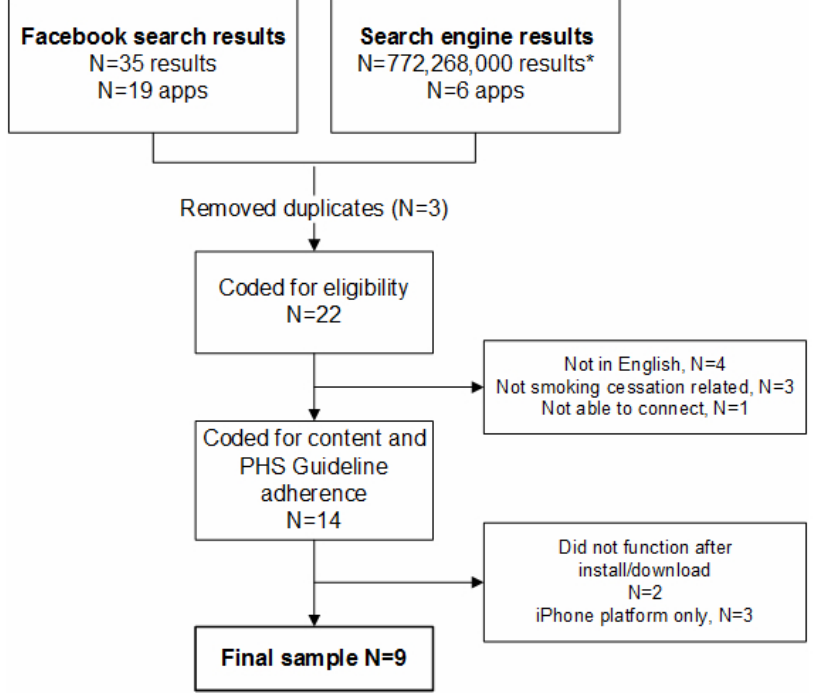
Figure 1. Study flow diagram from search results to final sample of apps reviewed (total number of results from Yahoo! search engine query were not